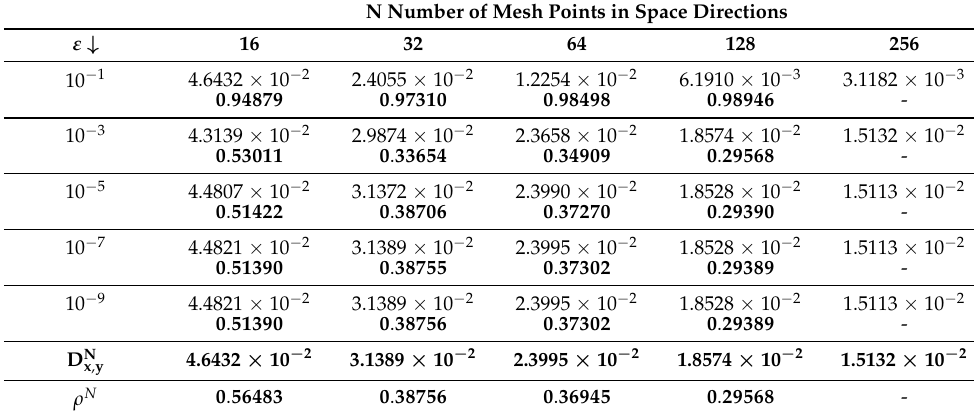
Figure 5. Maximum error of Example 2. Table 2. Maximum error and order of convergence for the Example 2 with M = 2 7